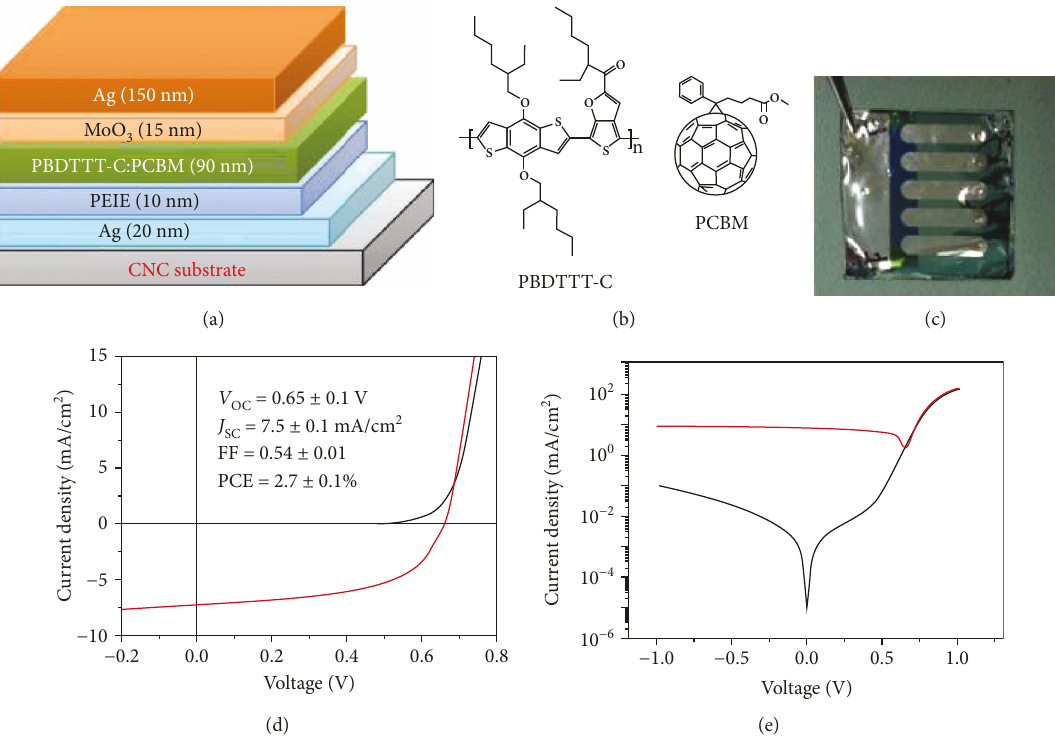
Figure 6: (a) Device architecture of a polymer solar cell deposited on CNC nanopaper. The evaporation of a thin layer of Ag allows deposition of the bottom electrode that was then modi fi ed through a thin layer of ethoxylated polyethylenimine (PEIE); (b) chemical structure of the active materials. PBDTTT-C: poly[(4,8-bis-(2-ethylhexyloxy)-benzo[1,2-b:4,5-b9]dithiophene)-2,6-diyl-alt- (4-(2-ethylhexanoyl)-thieno[3,4-b]thiophene)-2,6-diyl], polymer donor; PCBM: phenyl-C61-butyric acid methyl ester, molecular acceptor; (c) a photograph of the polymer solar cell deposited on nanopaper; (d) JV characteristics of the solar cell in the dark (black) and under illumination on the nanopaper side (red); (e) JV characteristics in a semilogarithmic scale. Reproduced from reference [35] with permission from Springer Nature.